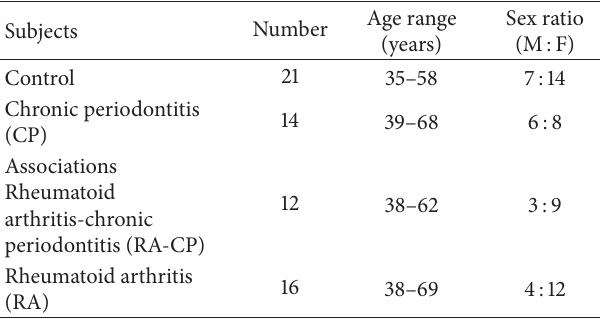
Table 1: The demographic and clinical data of the studied individu-